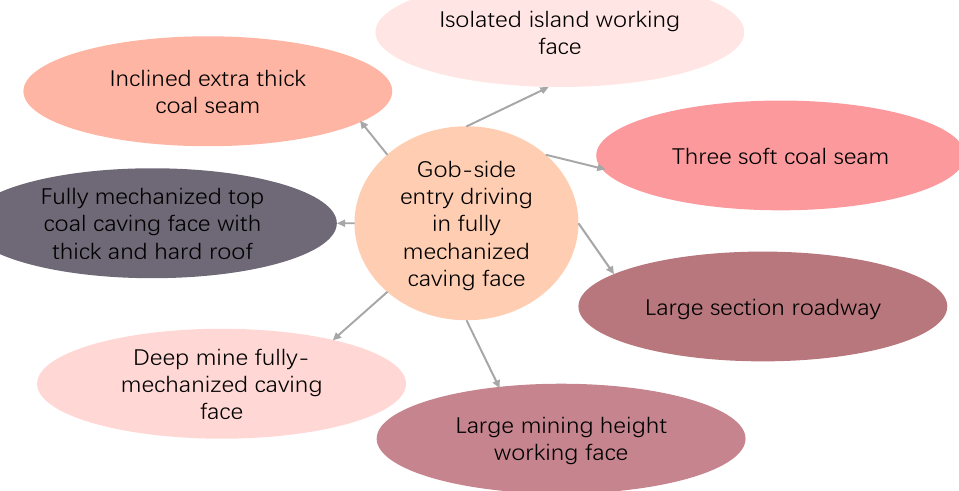
Figure 1. Some research directions of gob-side entry driving in fully mechanized caving mining.